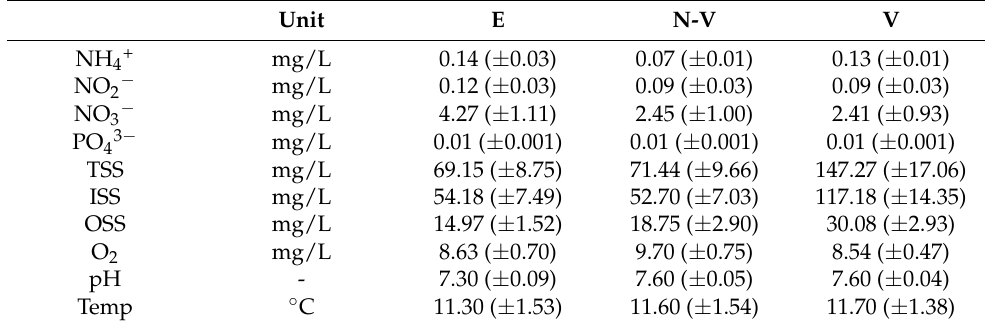
Table 5. Mean values ( ± st.err.) of water parameters at the three sampling sites (E = water entrance; N-V = non-vegetated site; V = vegetated